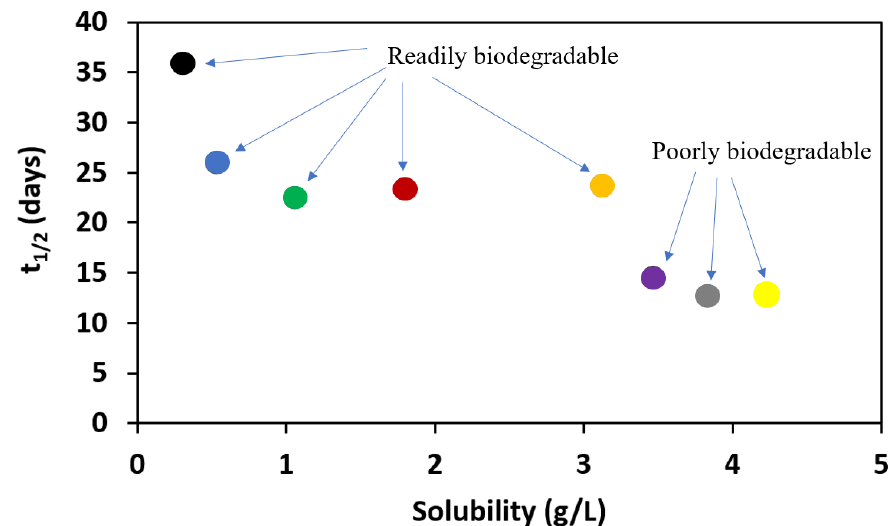
Figure 6. Dependence of half-life of the alkyl esters of L-valine on its solubility: [ValOMe][IBU]—black dot, [Val-